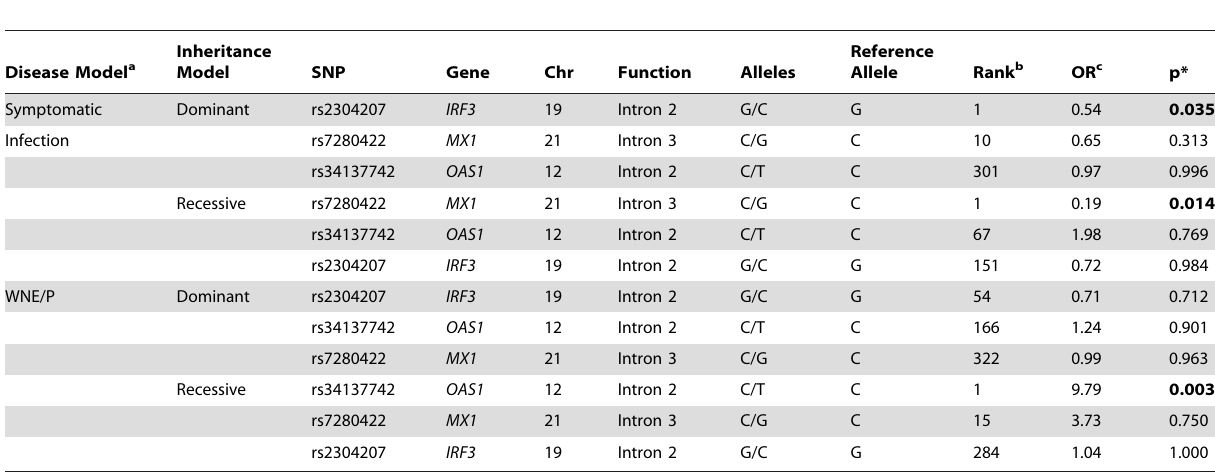
Table 3. Logistic regression analysis odds ratios (OR) of significant SNP associations with WNV infection or West Nile encephalitis/ paralysis